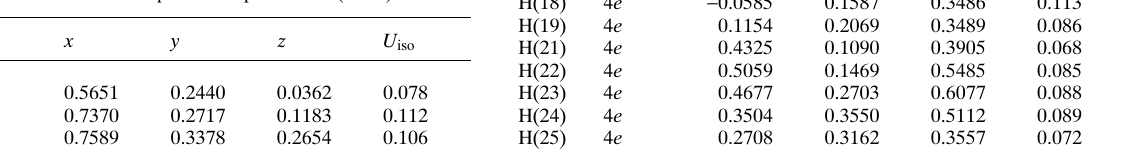
Table 2. Atomic coordinates and displacement parameters (in Å 2 ) .